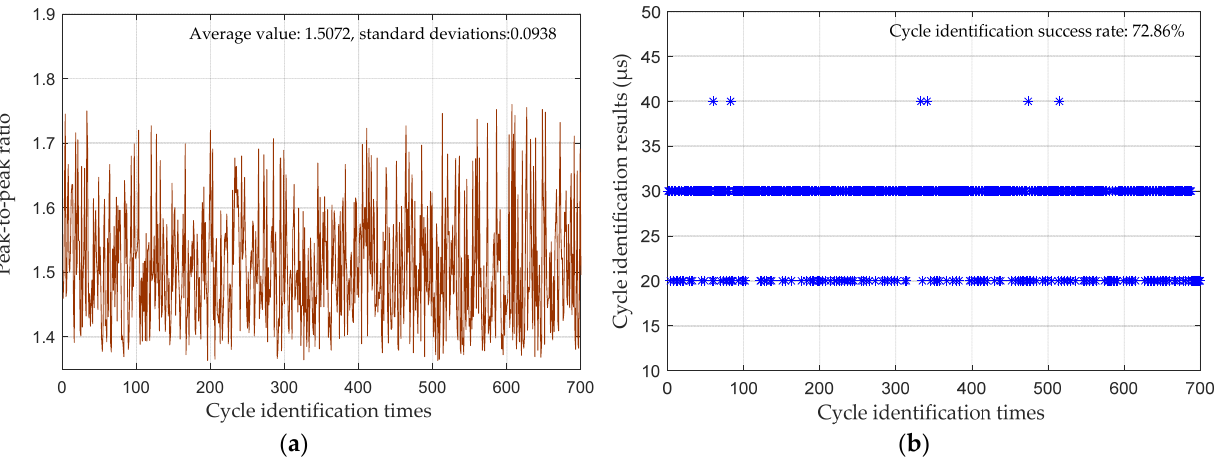
Figure 17. Results of cycle identification for Test 3: ( a ) peak–peak ratio; ( b ) cycle identification result.